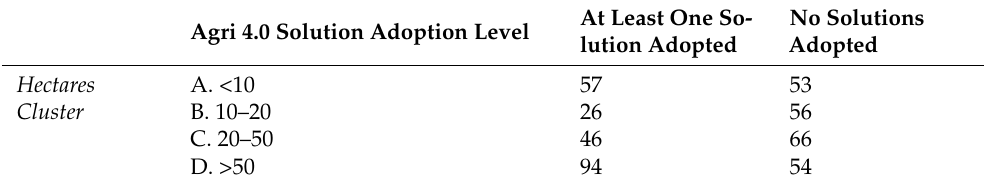
Table 10. Pearson’s χ 2 test for adoption level and land size